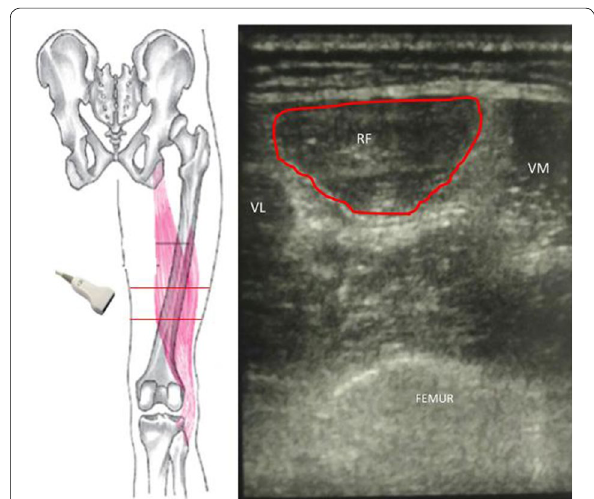
Fig. 2 Muscle cross-sectional area. This figure depicts the cross-sectional area of the rectus femoris perpendicular to its longitudinal axis. The quadriceps femoris is a group of muscles composed by three vastus muscles (medialis, intermedius, and lateralis) and the rectus femoris which presents a proximal insertion in the anterior inferior iliac spine and other insertion in the supra-acetabular sulcus. Left side: standardized level of ultrasound scan of the lower limb; in the supine position, the probe should be placed at 2/5 of an imaginary line between the anterior parts of the thigh from the anterior inferior iliac spine to the midpoint of the proximal border of the patella. Right side: the figure depicts the cross-sectional area (red circle) of the rectus femoris (RF) perpendicular to its longitudinal axis. VI vastus intermedius, VM vastus